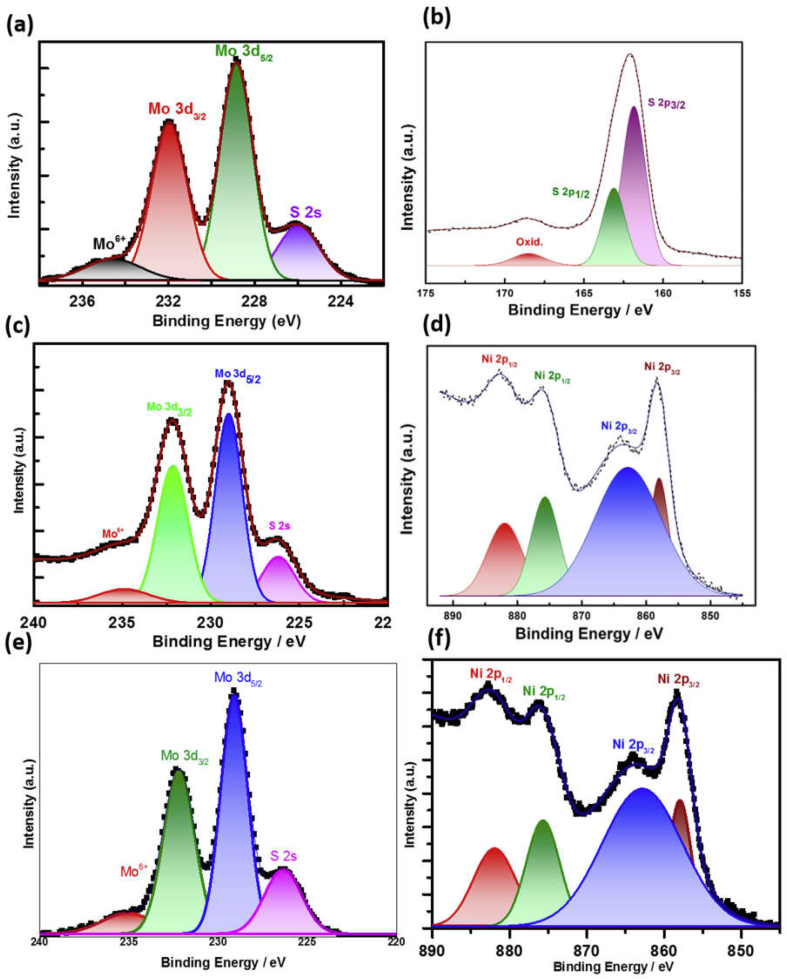
XPS spectra of (a,b) MoS2, (c,d) MoS2/NiO NPs, and (e,f) MoS2/NiO/MWCNT nanocomposite.